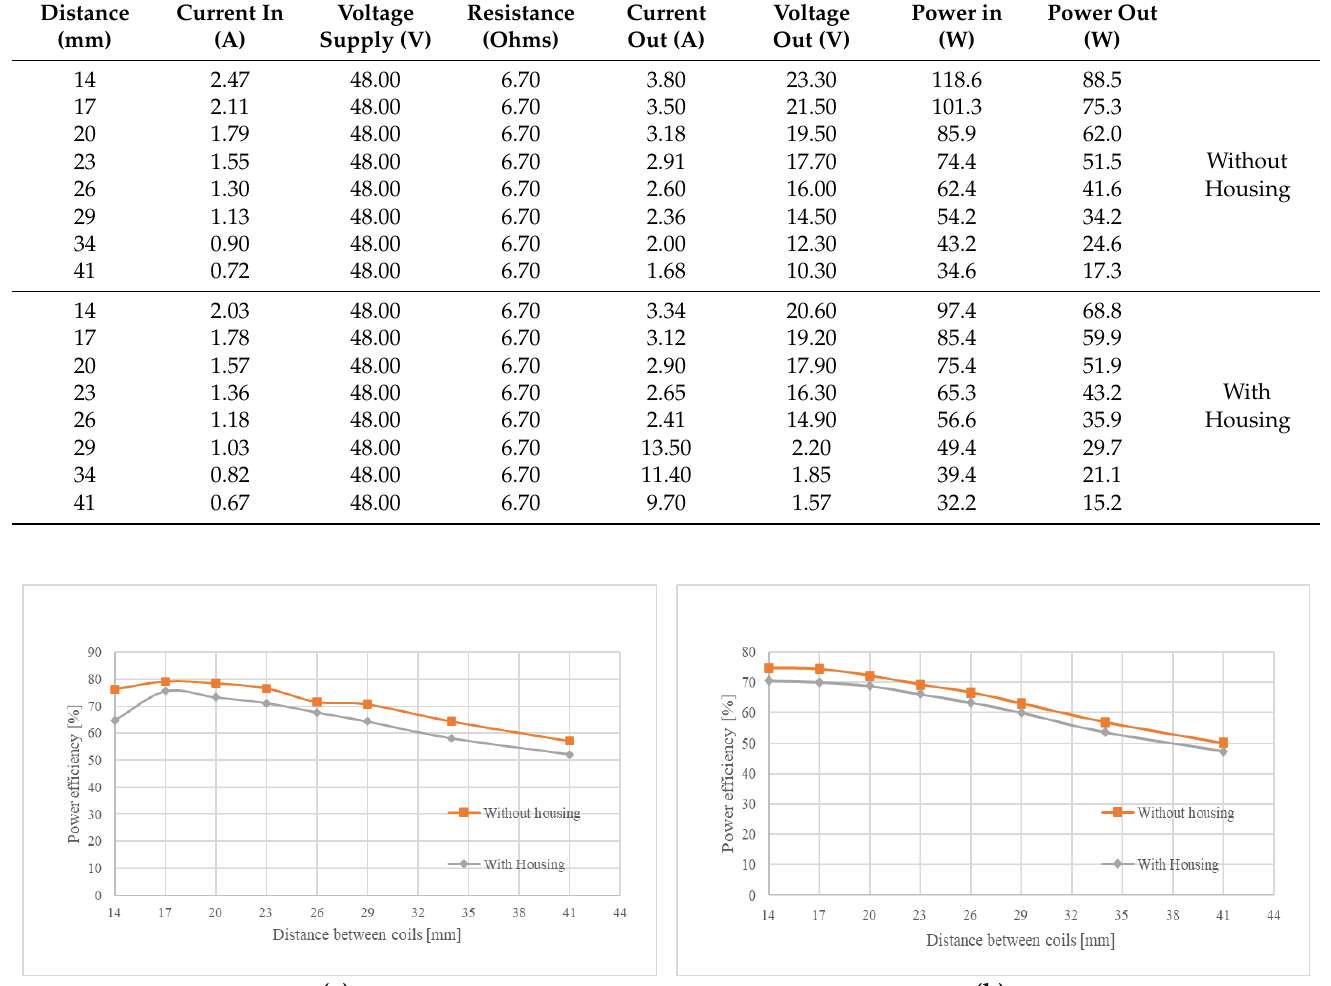
Figure 16. Experimental WCH validation in underwater environment: housings ready for testing ( a ) and housings being tested completely submerged ( b ). Table 14. Comparison between air and water: electric parameters registered during testing of wire- less modules power efficiency.